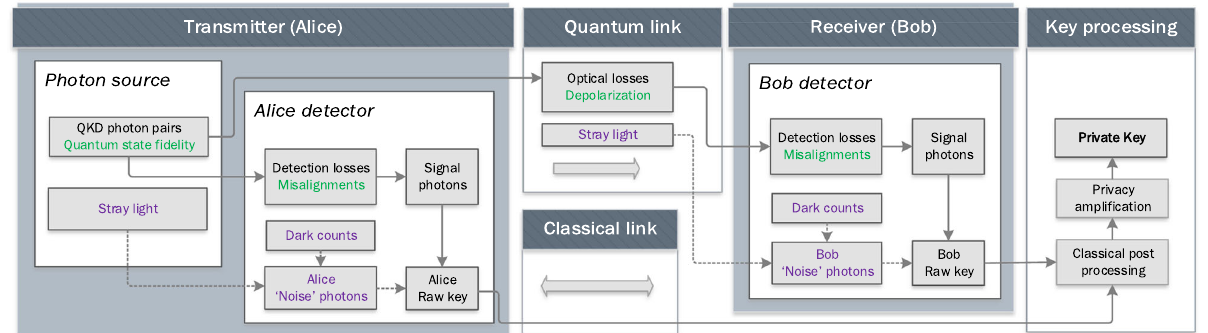
Fig. 5 Noise contributions to entanglement-based QKD between Alice (transmitter) and Bob (receiver) in a scenario such as Fig. 1 frame a . Effects determining the fi delity of the quantum states (visibility) are shown in green. Sources of unwanted photons are shown in purple with dotted connector lines. A WCP BB84 con fi guration would look similar, except Alice would have a random number generator selecting the polarization bases for her photon source and would not have a